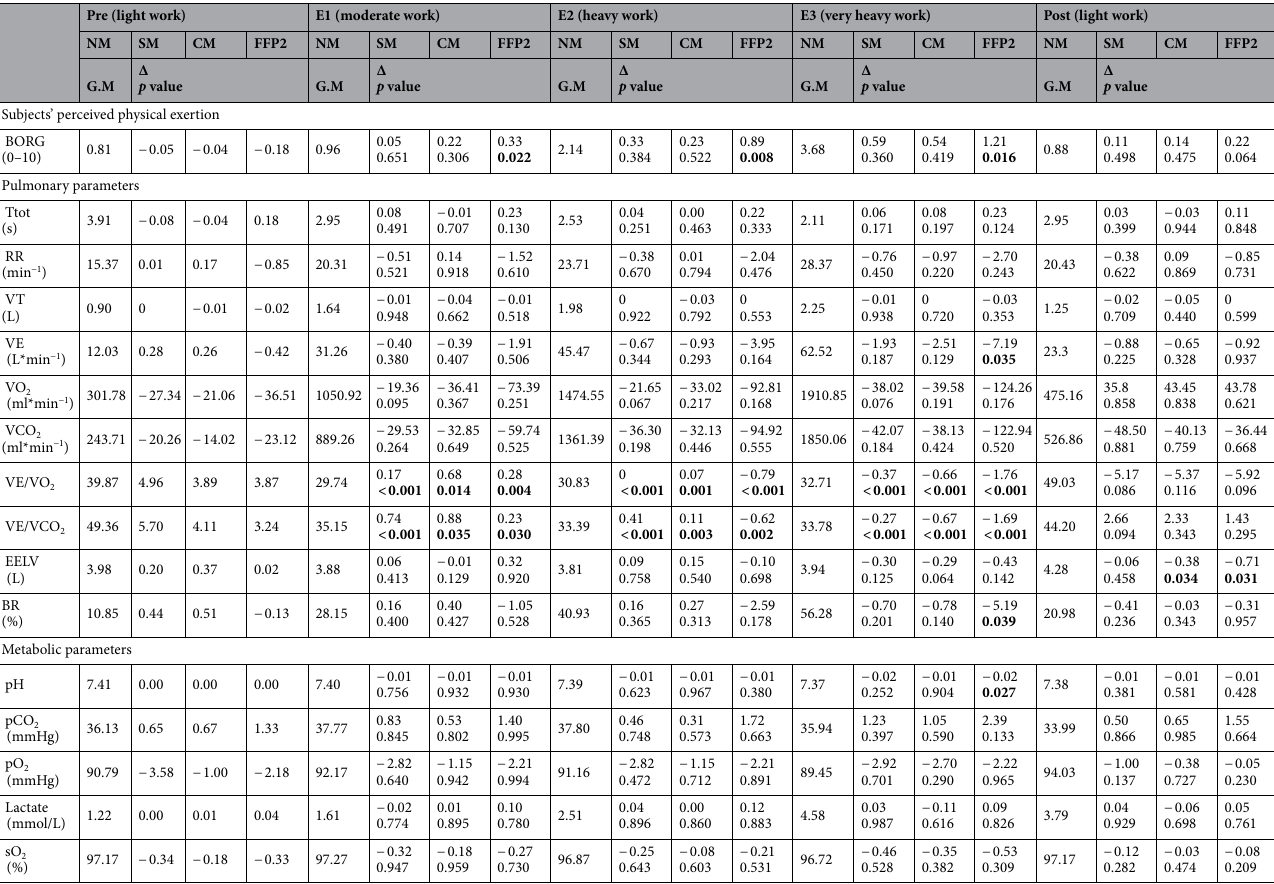
Table 3. CPET results of generalized linear mixed model (GLM model) analysis of 40 subjects without mask (NM) and with three different mask types (SM, CM, FFP2). BORG Borg scale, BR Breathing reserve, CM Community mask, CPET Cardiopulmonary exercise test (spiroergometry), Δ Difference to NM, EELV End- expiratory lung volume, FFP2 Filtering face piece class 2, G.M. Geometric mean, NM No mask, pCO 2 Partial pressure of carbon dioxide, pO 2 Partial pressure of oxygen, pH Potential of hydrogen in blood, RR Respiratory rate, sO 2 Haemoglobin oxygen saturation, SM Surgical mask, Tin Inspiratory time, Tex Expiratory time, Ttot Inspiratory and expiratory time, VCO 2 Carbon dioxide production, VE Minute ventilation, VE/VCO 2 Ventilation per litre of carbon dioxide, VE/VO 2 Ventilation per litre of oxygen, VO 2 Oxygen uptake, VT Tidal volume. Masks were tested using the mask adapter (details see Methods). The situation without mask in each specific load level (pre, E1, E2, E3, post) was always used as reference. For NM geometric mean (G.M.), for the three mask types (SM, CM, FFP2) differences (Δ) to NM and p values are shown. Significant values are in